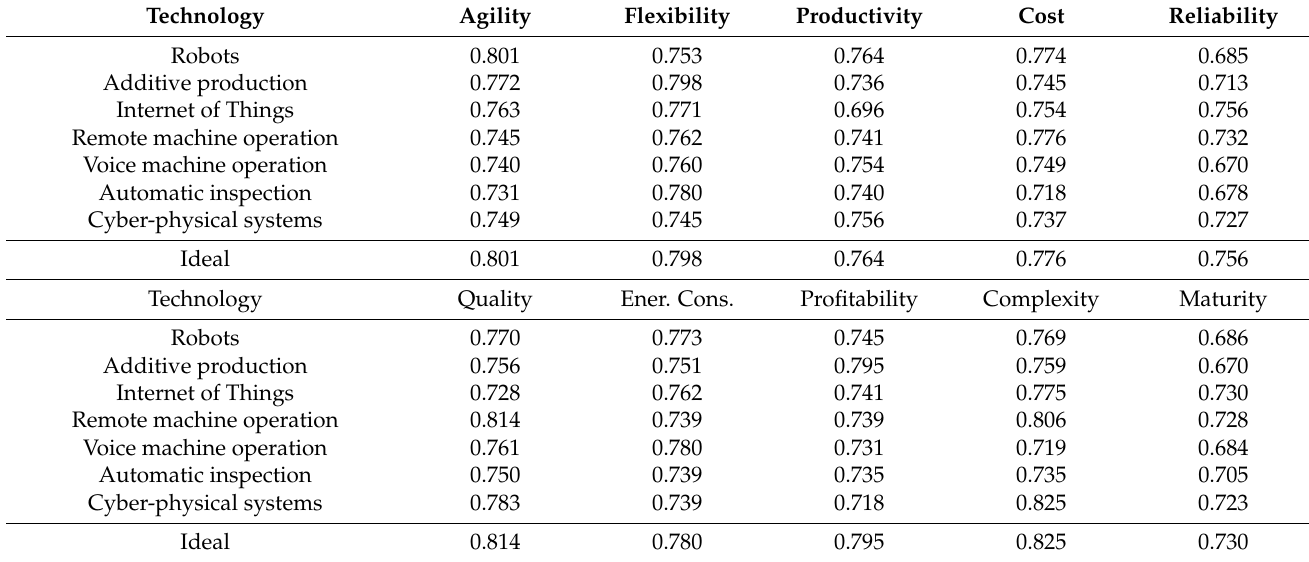
Table A7. The utility matrix of weighted arithmetic